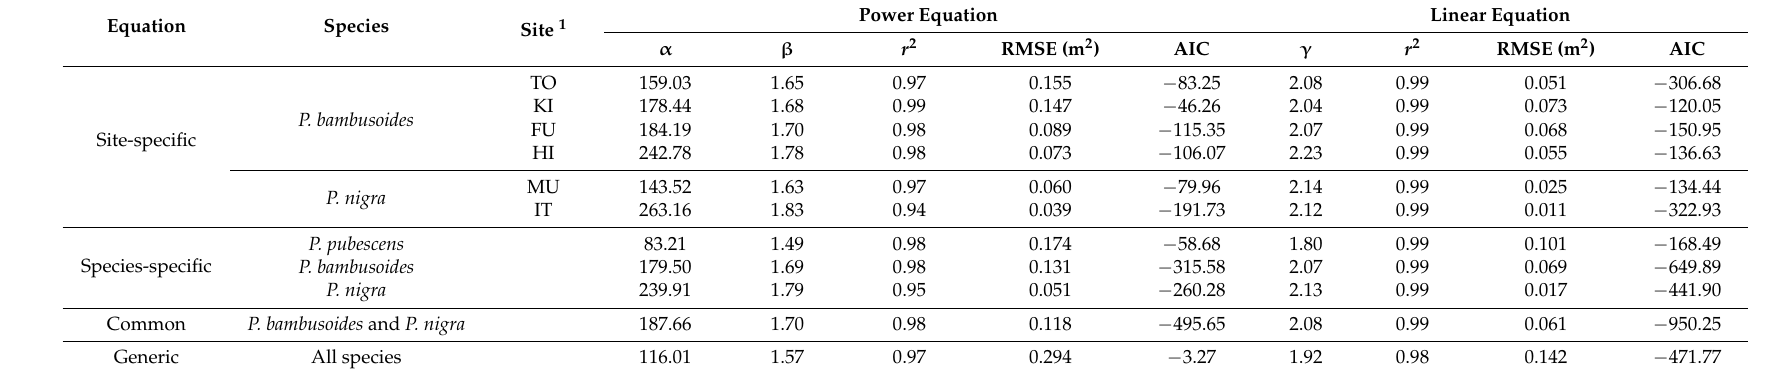
Table 3. Parameter estimates of the developed allometric equations and their fit